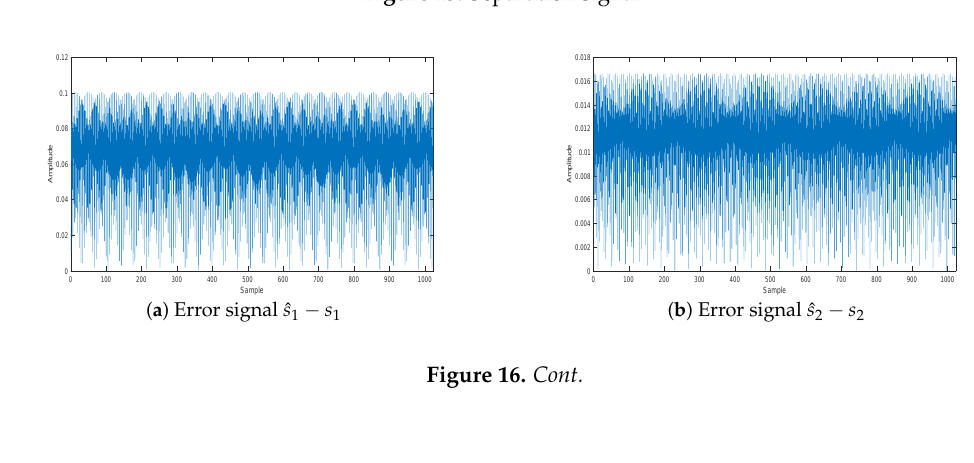
Figure 15. Separation signal.